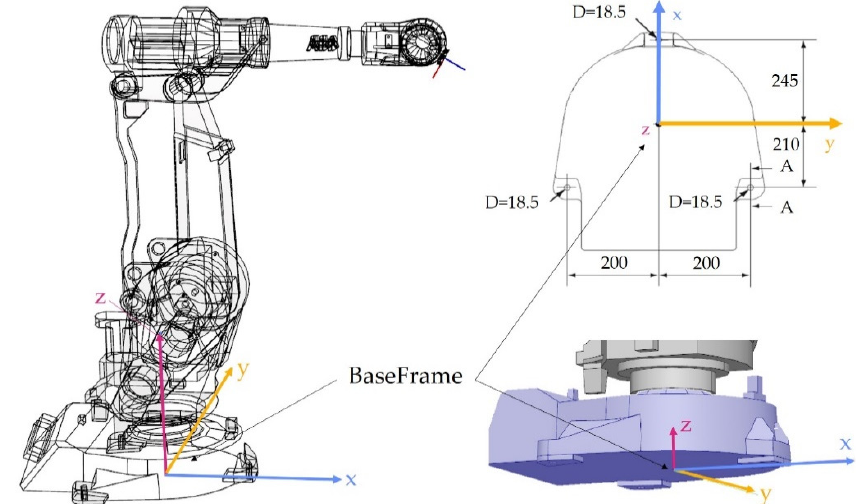
Figure 6. Position of the Base Frame in the ABB IRB 2400 robot.